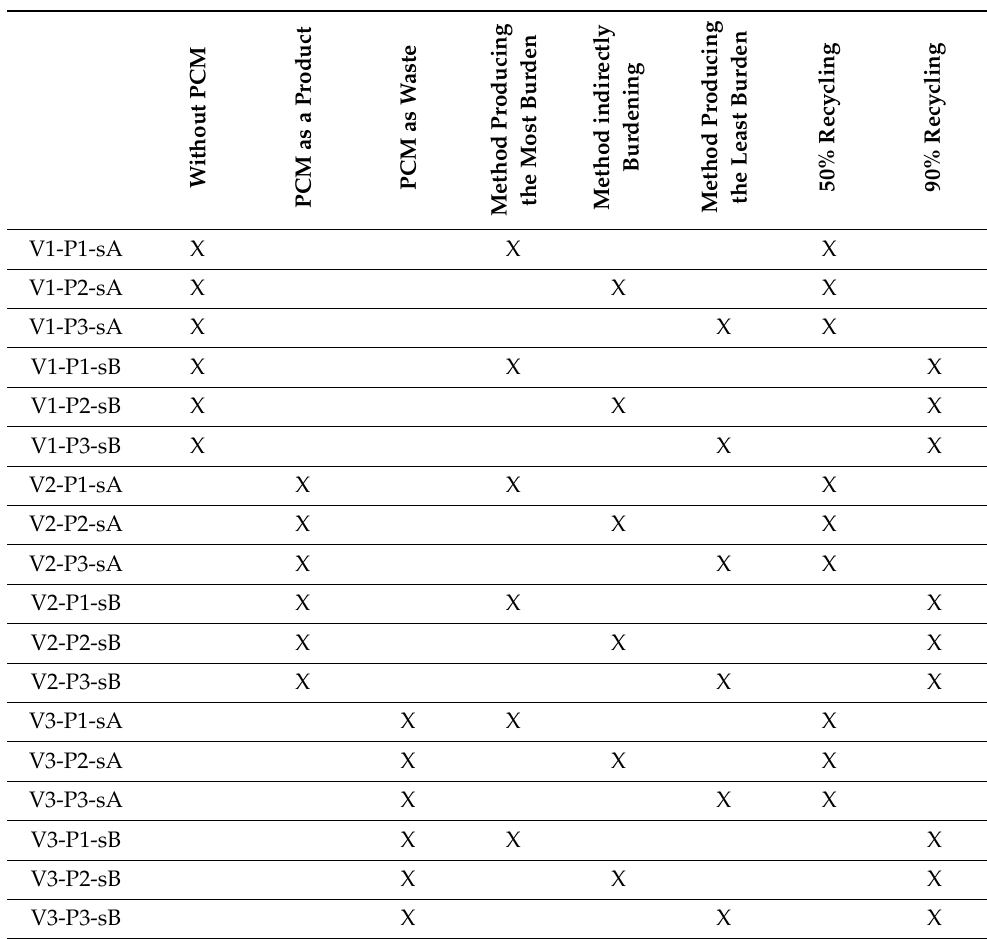
Table 3. Specification of the analyzed